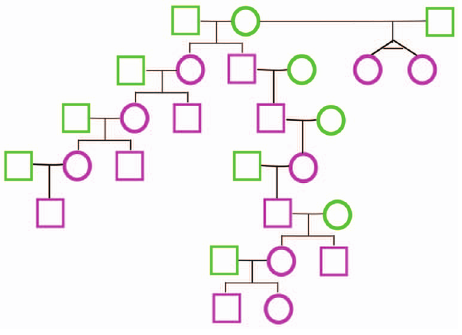
Figure 1. A simulated 26-member, 7-generation pedigree. Green symbols indicate founders that were sequenced by CGI, and purple ones indicate children whose genotyping were simulated. The topology of the pedigree was chosen to enable testing of diverse relationship estimations.